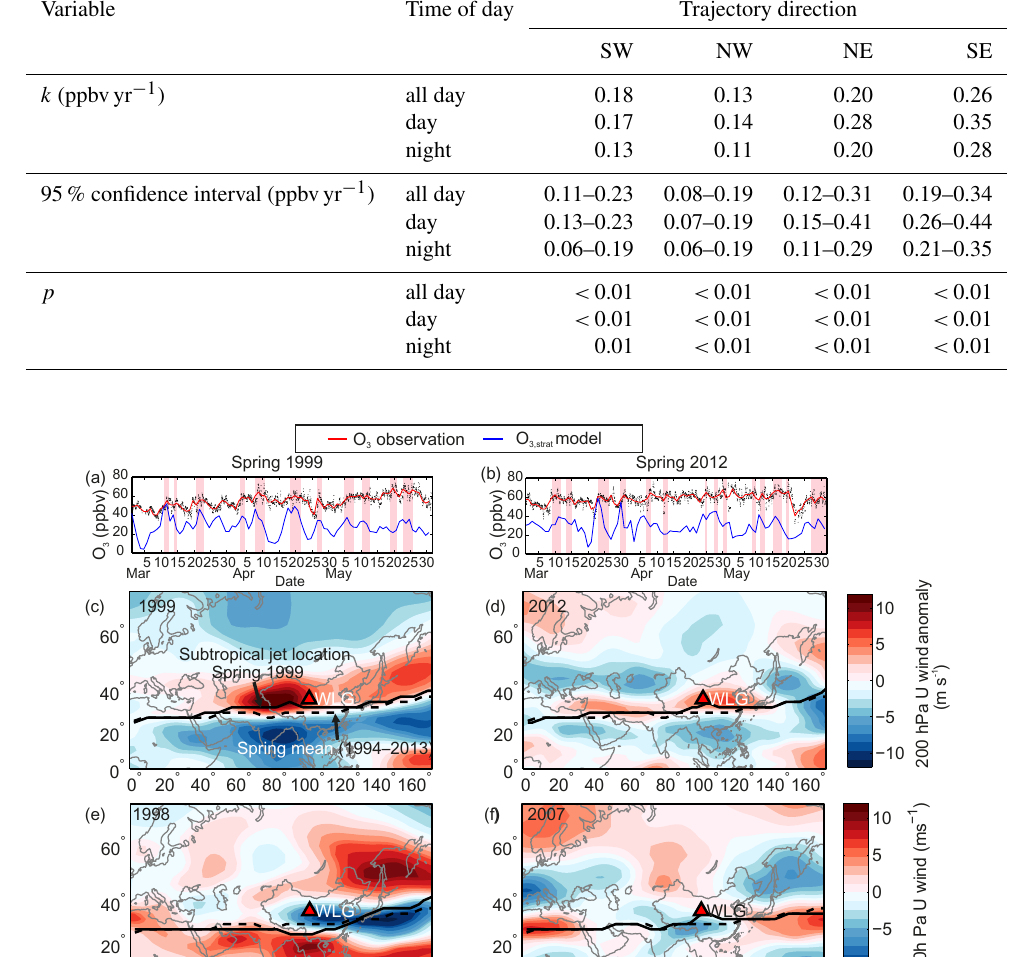
Table 3. The Kendall’s variation slope ( k , ppbvyr − 1 ) of ozone concentrations associated with different trajectory directions, the according confidence interval, and p values.